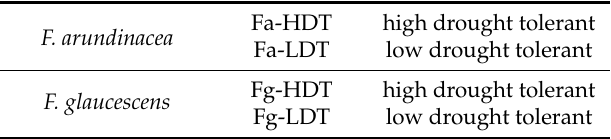
Figure 6. A comparison of physiological and molecular reactions in the HDT (Fa-HDT, Fg-HDT) and LDT (Fa-LDT, Fg-LDT) genotypes of F. arundinacea and F. glaucescens to drought stress on the 11th day of water deficit (D3), unless otherwise stated (D1—3rd and D2—6th day of drought) in relation to the control; and 10 days after re-hydration initiation (RH) in relation to D3. Table 1. Abbreviations of F. arundinacea and F. glaucescens genotypes used in the analyses and their